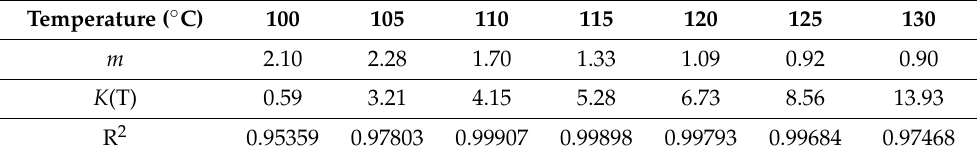
Table 1. Ozawa parameters for the non-isothermal cold crystallization of PLA. Temperature ( ◦ C) 100 105 110